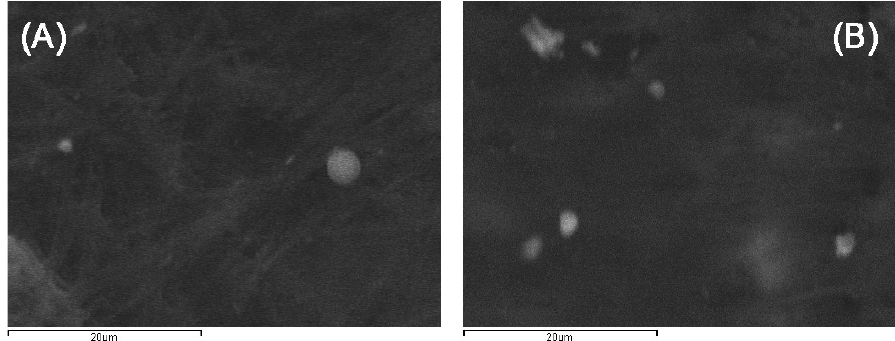
Figure A2. SEM micrograms of Paclitaxel loaded TEHA-co-PDLLA nanoparticles for 1/70 ( A ) and 1/140; ( B ) TEHA to PDLLA.